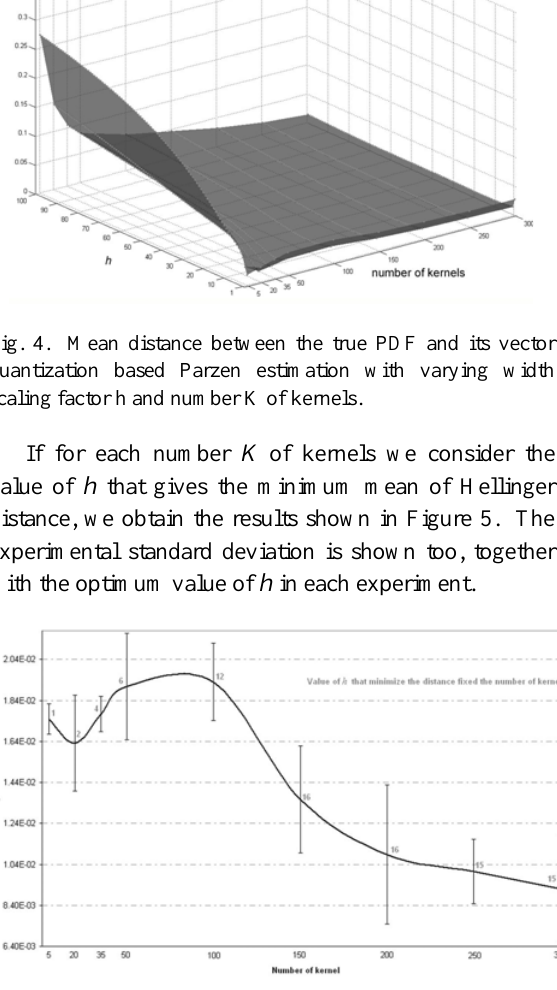
Fig. 3. Distance between the true PDF and its Parzen windows estimation with varying number of data. The kernel width σ (s in the figure) is a parameter.